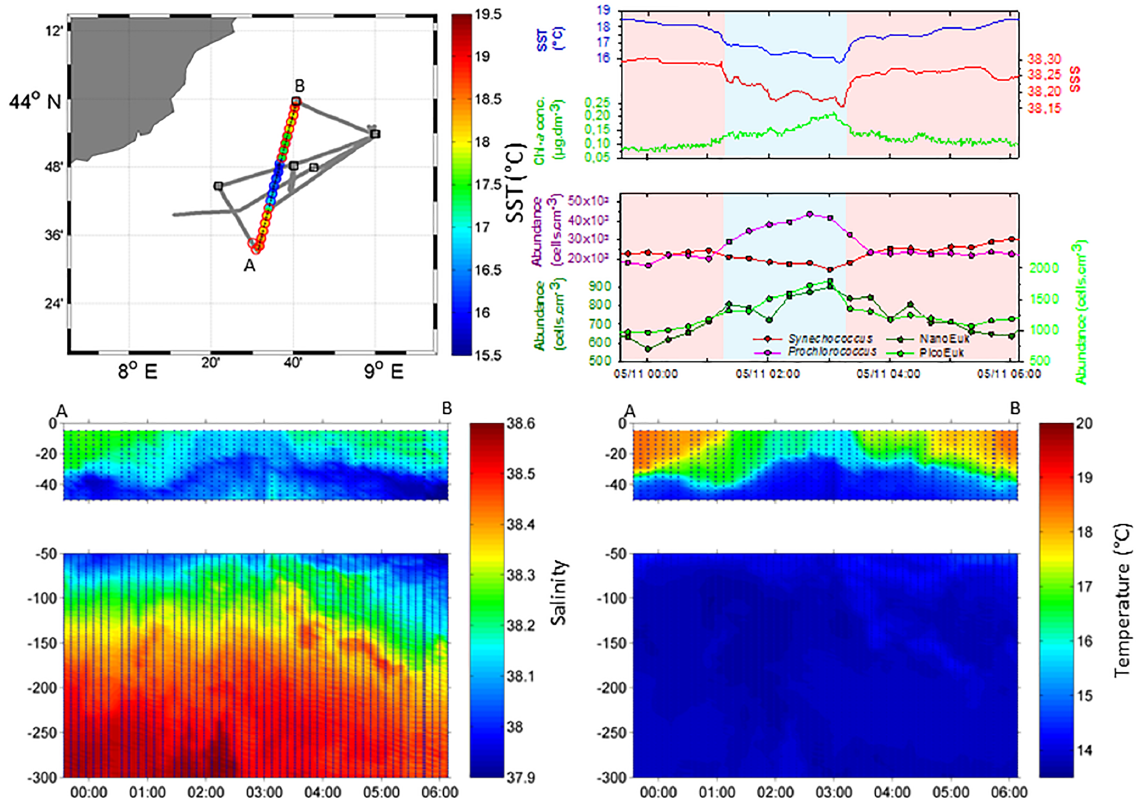
Figure 3. Continuous vertical profiles of salinity and temperature from the surface to 300m in depth between points A and B from 00:00 to 06:00 (local time) on 5 November. Associated SST (in ◦ C), SSS and Chl a concentration (in µgdm − 3 ) from continuous surface